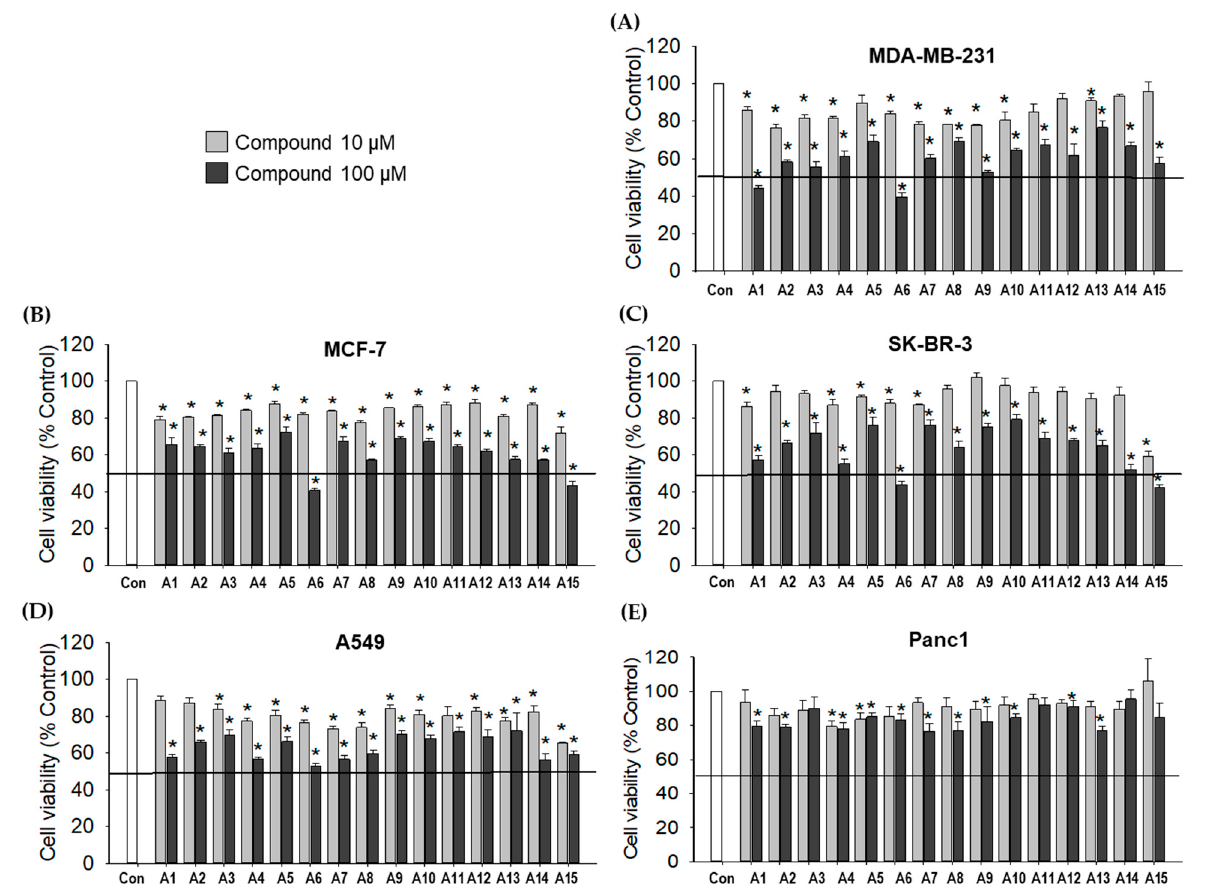
Figure 2. Effects of indole-based benzenesulfonamide derivatives on the viability of cancer cells. ( A ) MDA-MB-231, ( B ) MCF-7, ( C ) SK-BR-3, ( D ) A549, and ( E ) Panc1 cells were treated with the test compounds (10 and 100 μ M) for 48 h under CoCl 2 -induced hypoxic condition. Control cells were treated with the media containing 0.2% dimethyl sulfoxide (DMSO) instead. Cell viability was determined by MTT assay as described in the Materials and Methods. The viability of vehicle (DMSO)-treated control cells was defined as 100%, and the viability of the cells treated with test compounds was expressed as a percentage of the control measured in the vehicle-treated cells in each cell line. Data are displayed as mean ± SEM from three independent experiments. * p < 0.05 vs. the vehicle-treated control cells. Con, control.